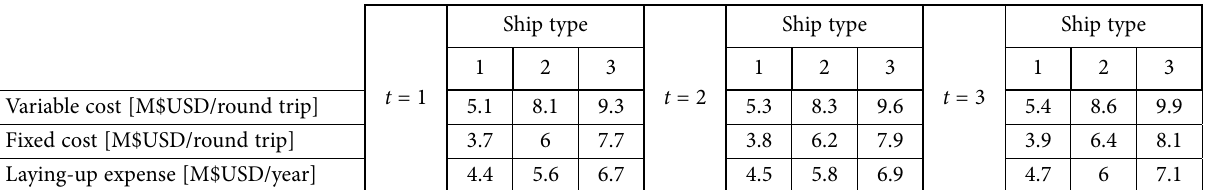
Table 3. Operational and laying-up costs by ship